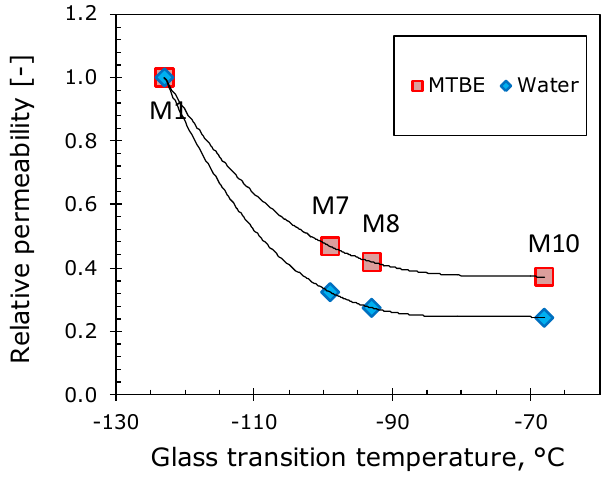
Figure 4. The dependences of the relative permeabilities of MTBE and water in polyalkylmethylsiloxanes on their glass transition temperature (relative to the corresponding values for M1).